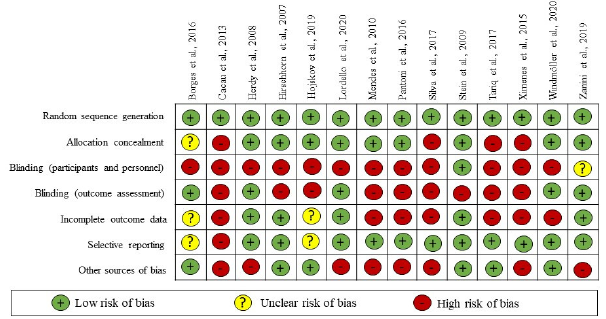
Fig. 2 - Assessment of risk of bias of the included